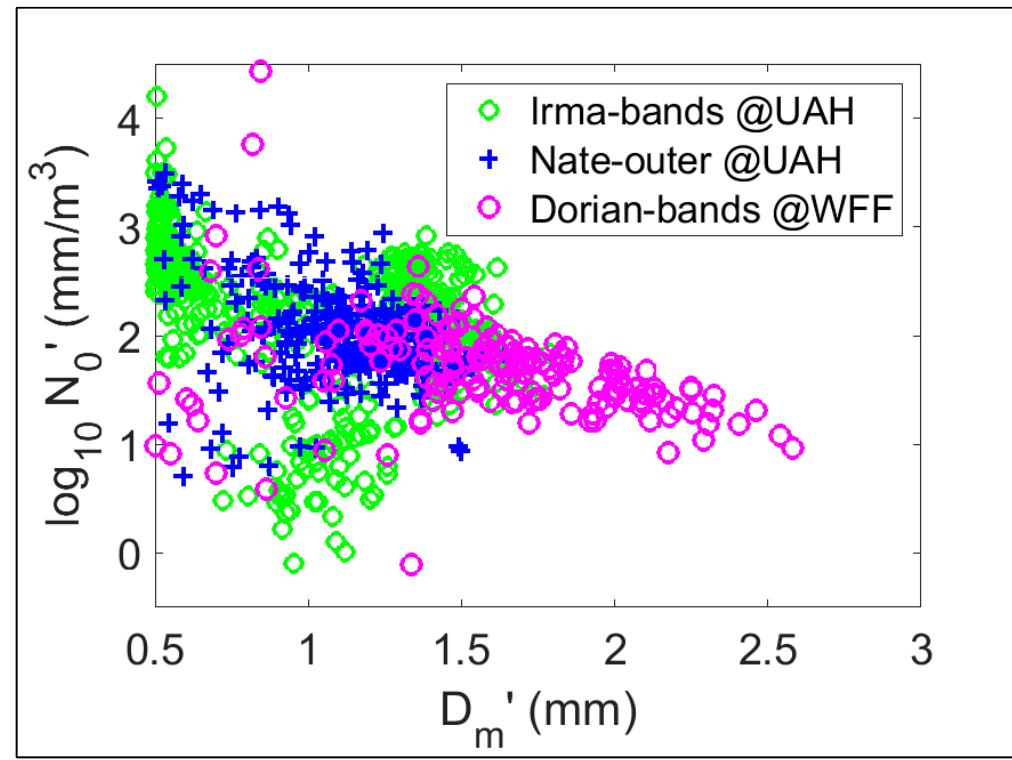
Figure 9. N 0 ʹ versus D m ʹ (same as D m ) from 3 min DSD for Dorian rainbands compared with those from the outer bands of hurricane Irma and from outer bands of tropical depression Nate, both at HSV.